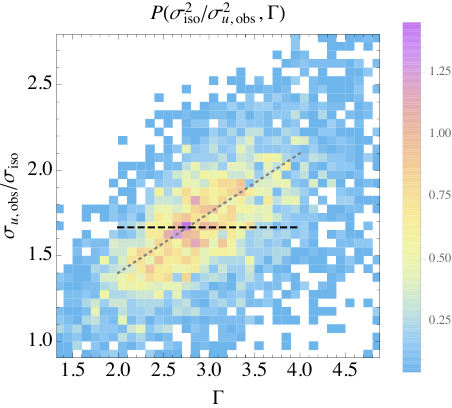
Figure 2. Ratio of observed streamwise to isotropic fluctuation magnitude versus (cid:48) obtained from spectral fits, plotted as joint probability density function P ( (cid:48),σ u, obs /σ iso ). Dashed (horizontal) √ line shows σ u, obs /σ iso = 5 / 3 corresponding to slope of dashed line in Fig. 1; dotted line shows the mean linear (cid:48) dependence of σ u, obs /σ iso